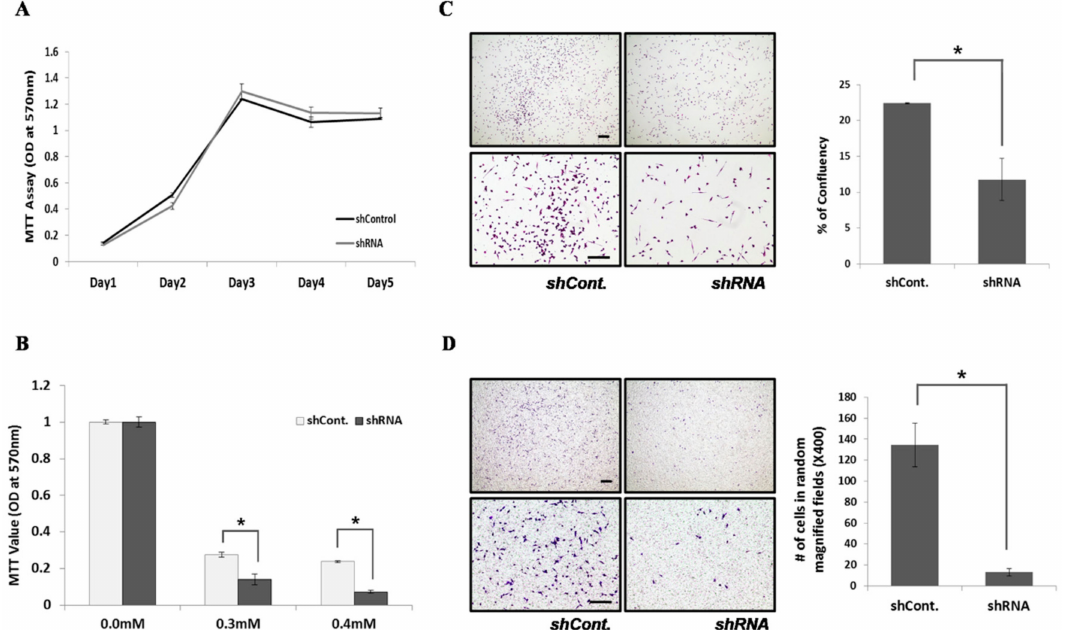
Figure 5. QSOX1 expression in lung cancer cells promotes cancer progression by anti-apoptotic, pro-migration and pro-invasion functions. ( A ) Cell proliferation of LLC transfected with shRNA control (shCont) or QSOX1 shRNA (shQSOX1) measured by MTT assay. ( B ) Cell survival from oxidative stress measured by MTT assays in various H 2 O 2 concentration conditions. ( C ) Using a Boyden chamber, the cell migration assay was carried out and cells at the lower chamber was stained and counted. ( D ) Using a Boyden chamber with the basement membrane Matrigel coated, the cell invasion assay was carried out and cells at the lower chamber was stained and counted. Scale bar, 100 µ